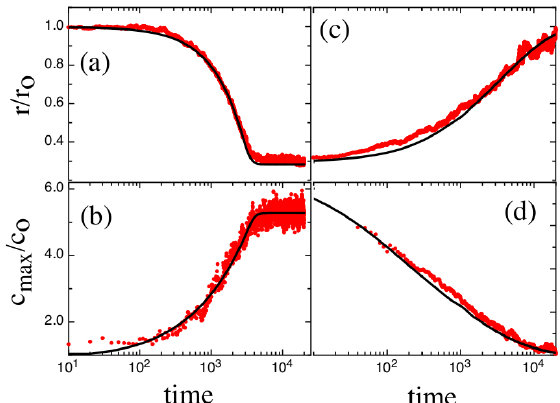
Figure 7. The chain extension and maximum concentration for a dynamic compression ( a , b ) and retraction (relaxation) process ( c , d ). The red line corresponds to BD results; the black curve corresponds to NPDE model output corresponding to the profile fits shown in Figures 4 and 6. The maximum profile concentration for the BD output for the transient compression process is obtained by taking a three-point running average of the simulation data to suppress concentration fluctuations at the peak position. The maximum profile concentration for the BD output for the retraction process is obtained by performing a fit of the concentration profile to a parabolic concentration model.